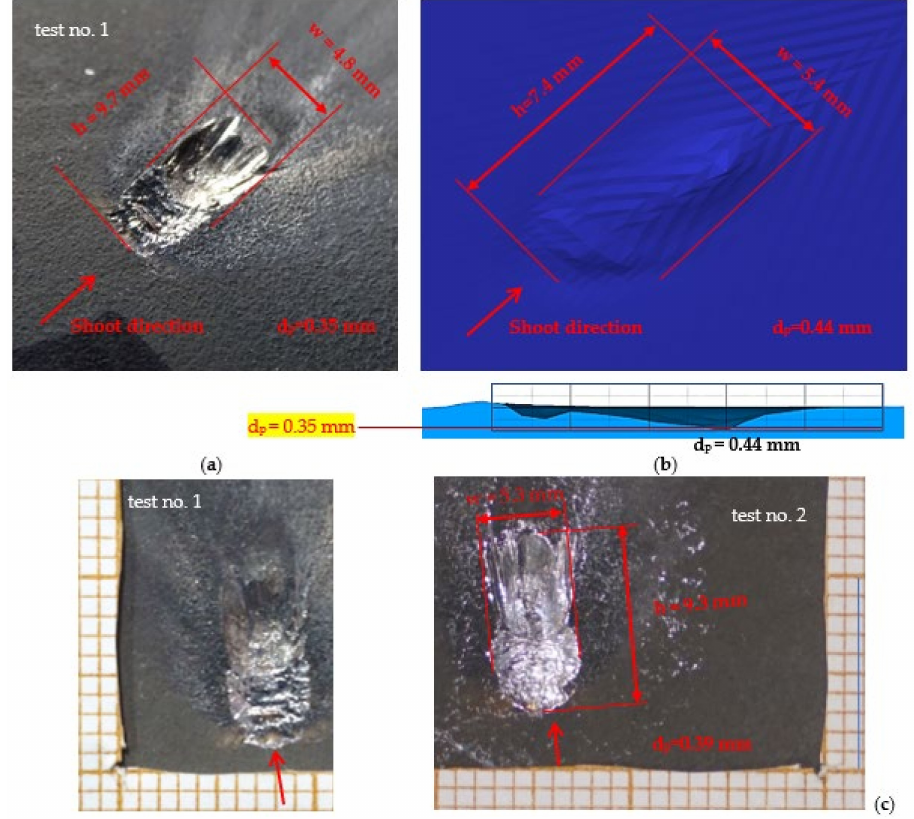
Figure 9. Trace after 5.56 × 45 mm HC (SS109) projectile impact onto Armox 600 armour plate: ( a ) experiment, ( b ) numerical simulation, ( c ) experiment—both tests (no. 1 and test no.